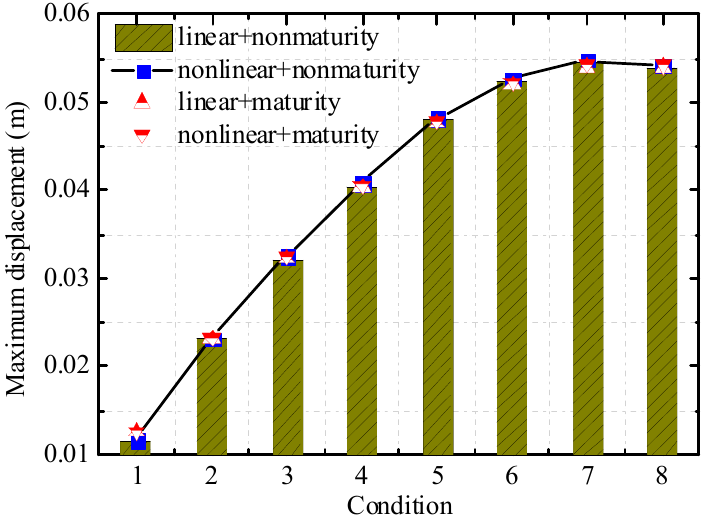
Figure 14. Comparison of maximum displacement under linearity and non-linearity of the structure for basic wind speed during the whole construction process.